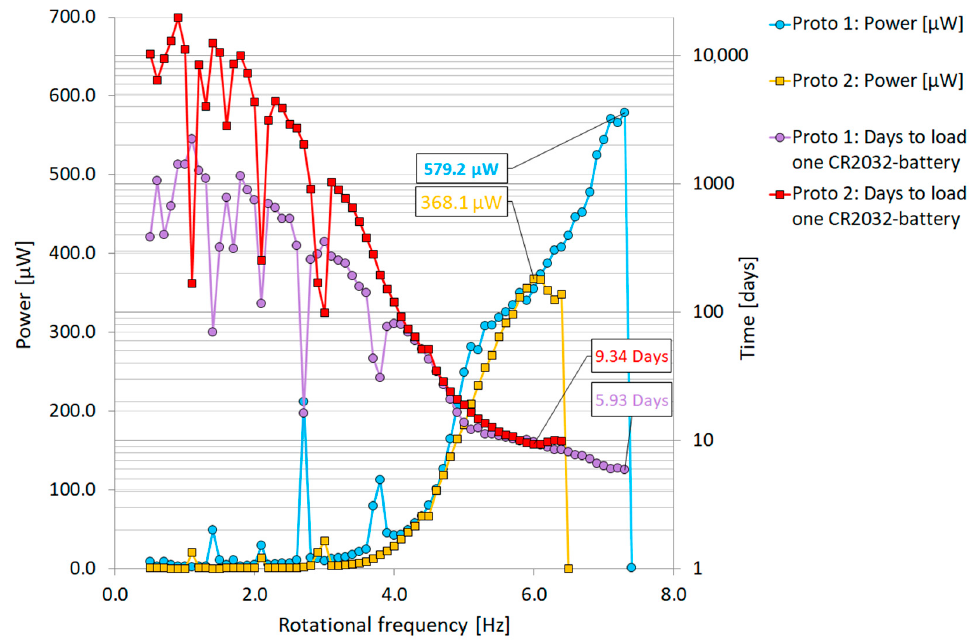
Figure 11. Piezoelectric energy harvesting cantilevers with a tungsten mass. Power as function of rotation frequency and calculated days to overcome a 220 mAh battery.